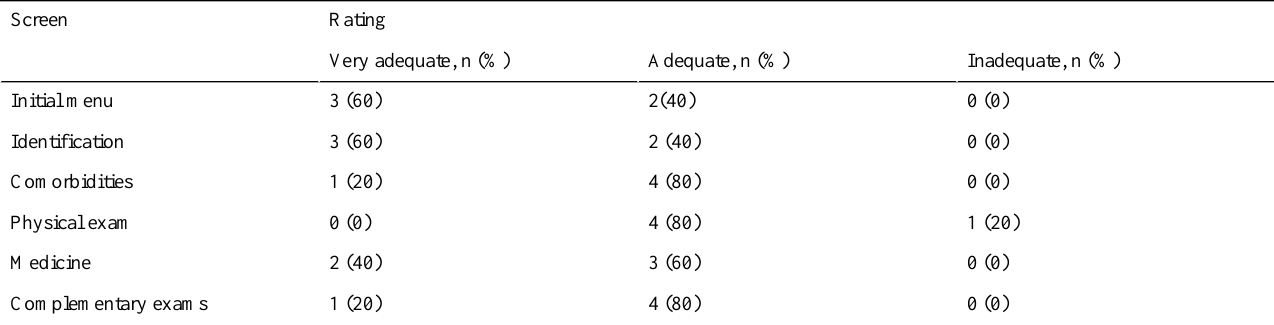
Table 1. Expert panel perception of TeleHAS for each screen